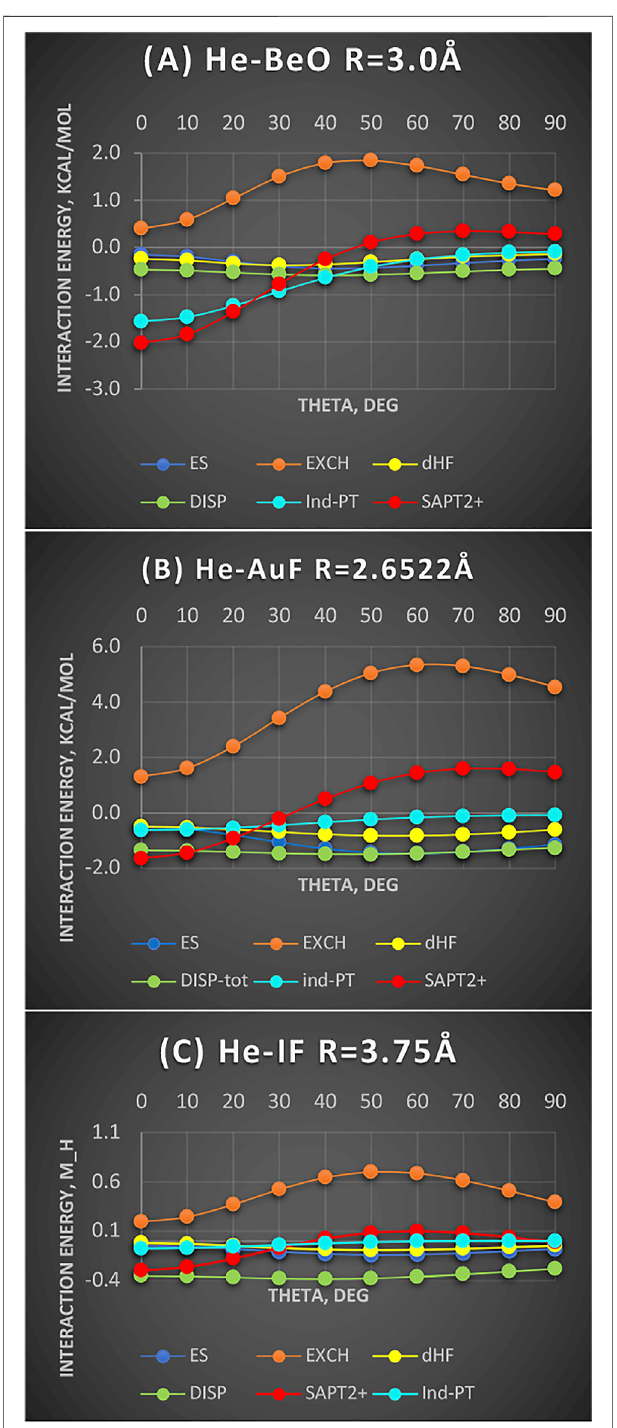
FIGURE 3 | Interaction energy terms for angular displacement in Jacobi coordinates: (A) He-BeO R = 3.0 Å (units kcal/mol), (B) He-AuF R = 2.6522Å (units kcal/mol), and (C) He-IF R = 3.75 Å (units mH).